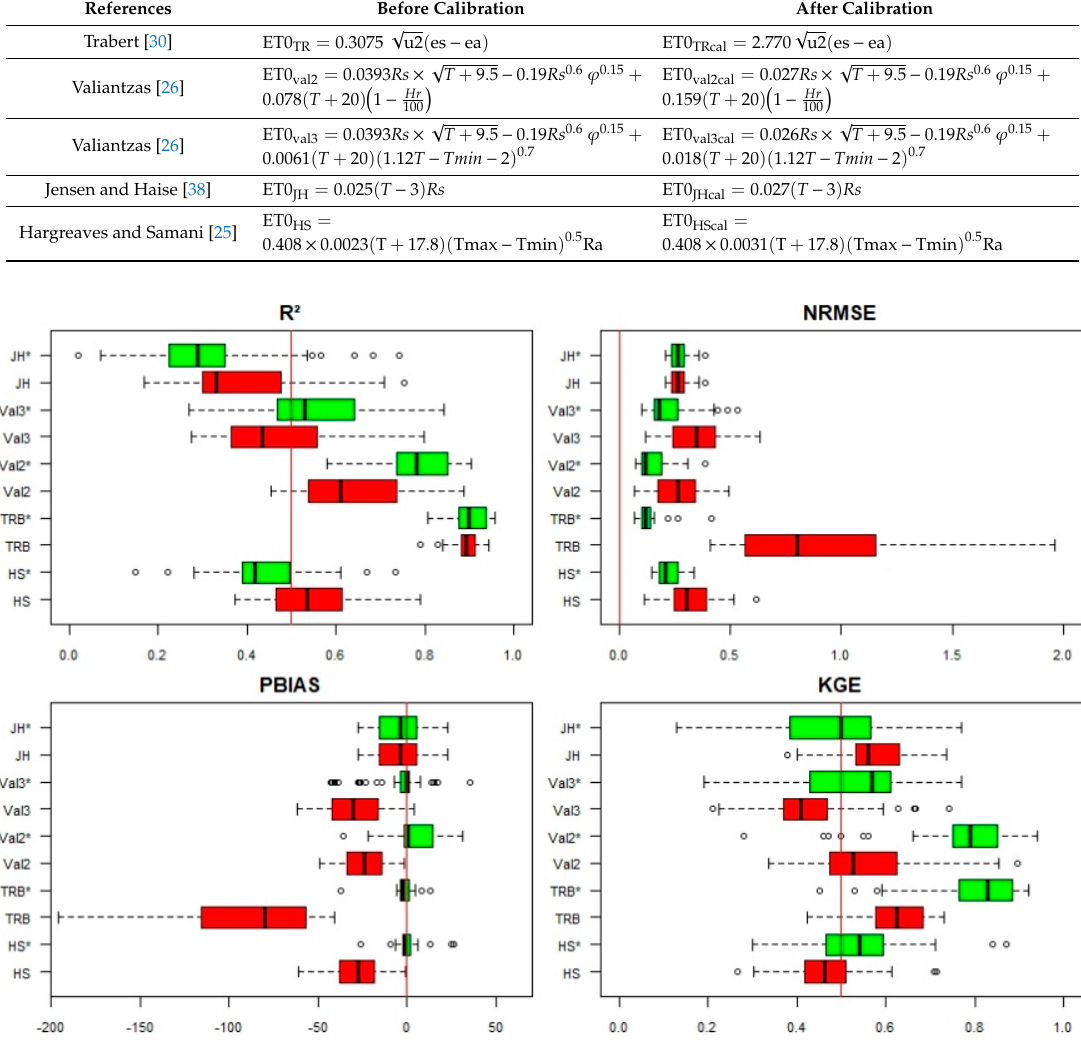
Figure 4. Method performance before and after calibration: (red color: before calibration; green color: after calibration). After